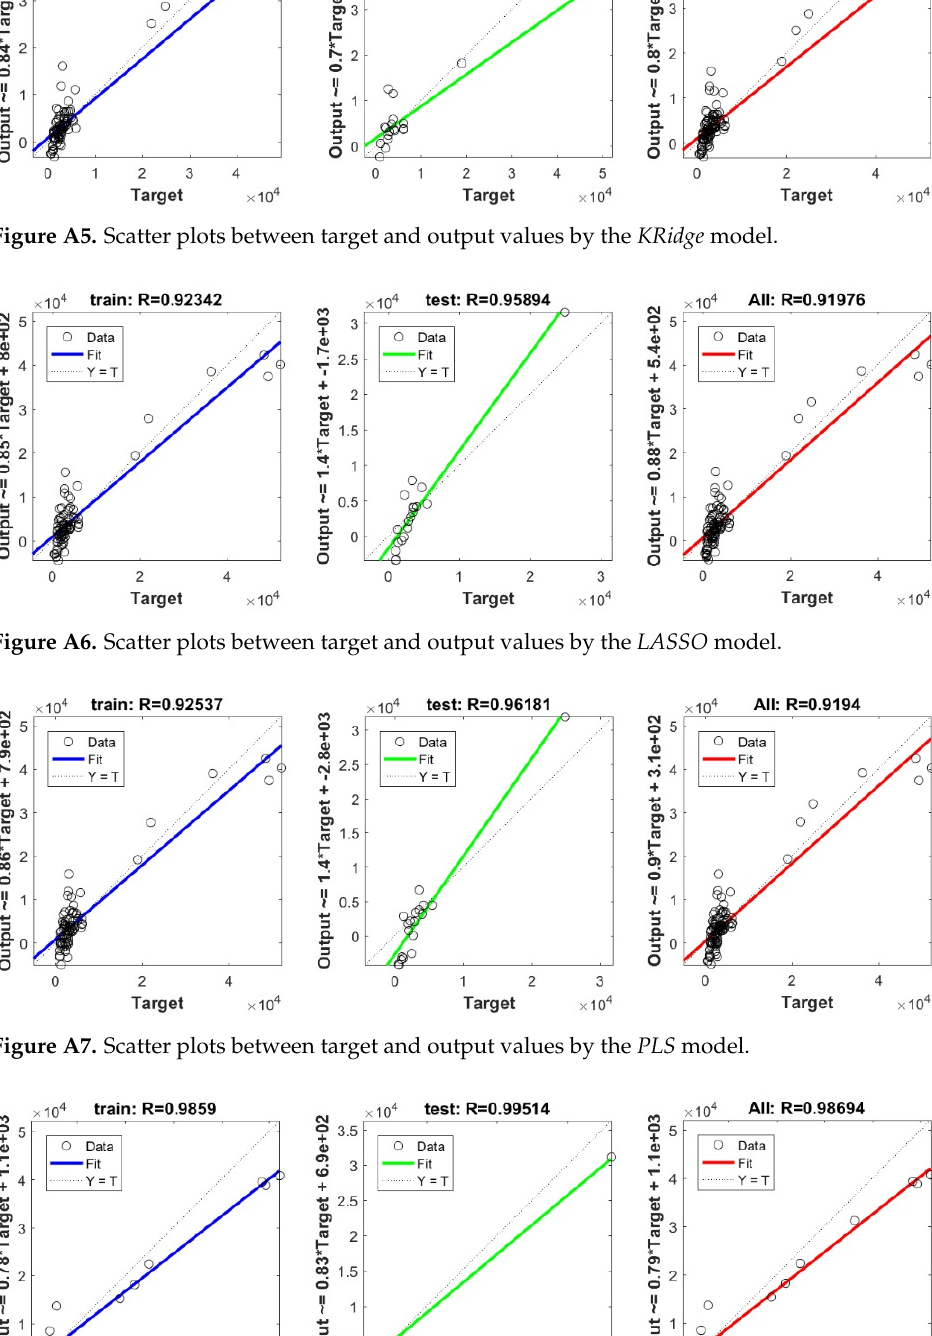
Figure A8. Scatter plots between target and output values by the RF model.